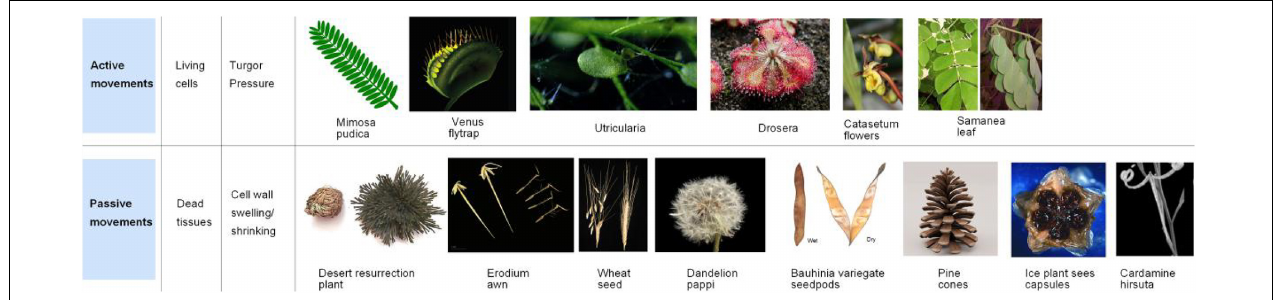
FIGURE 1 | The movement classification based on whether the systems are biochemical energy-based actuation (active movements) or humidity-driven actuation (passive movements).